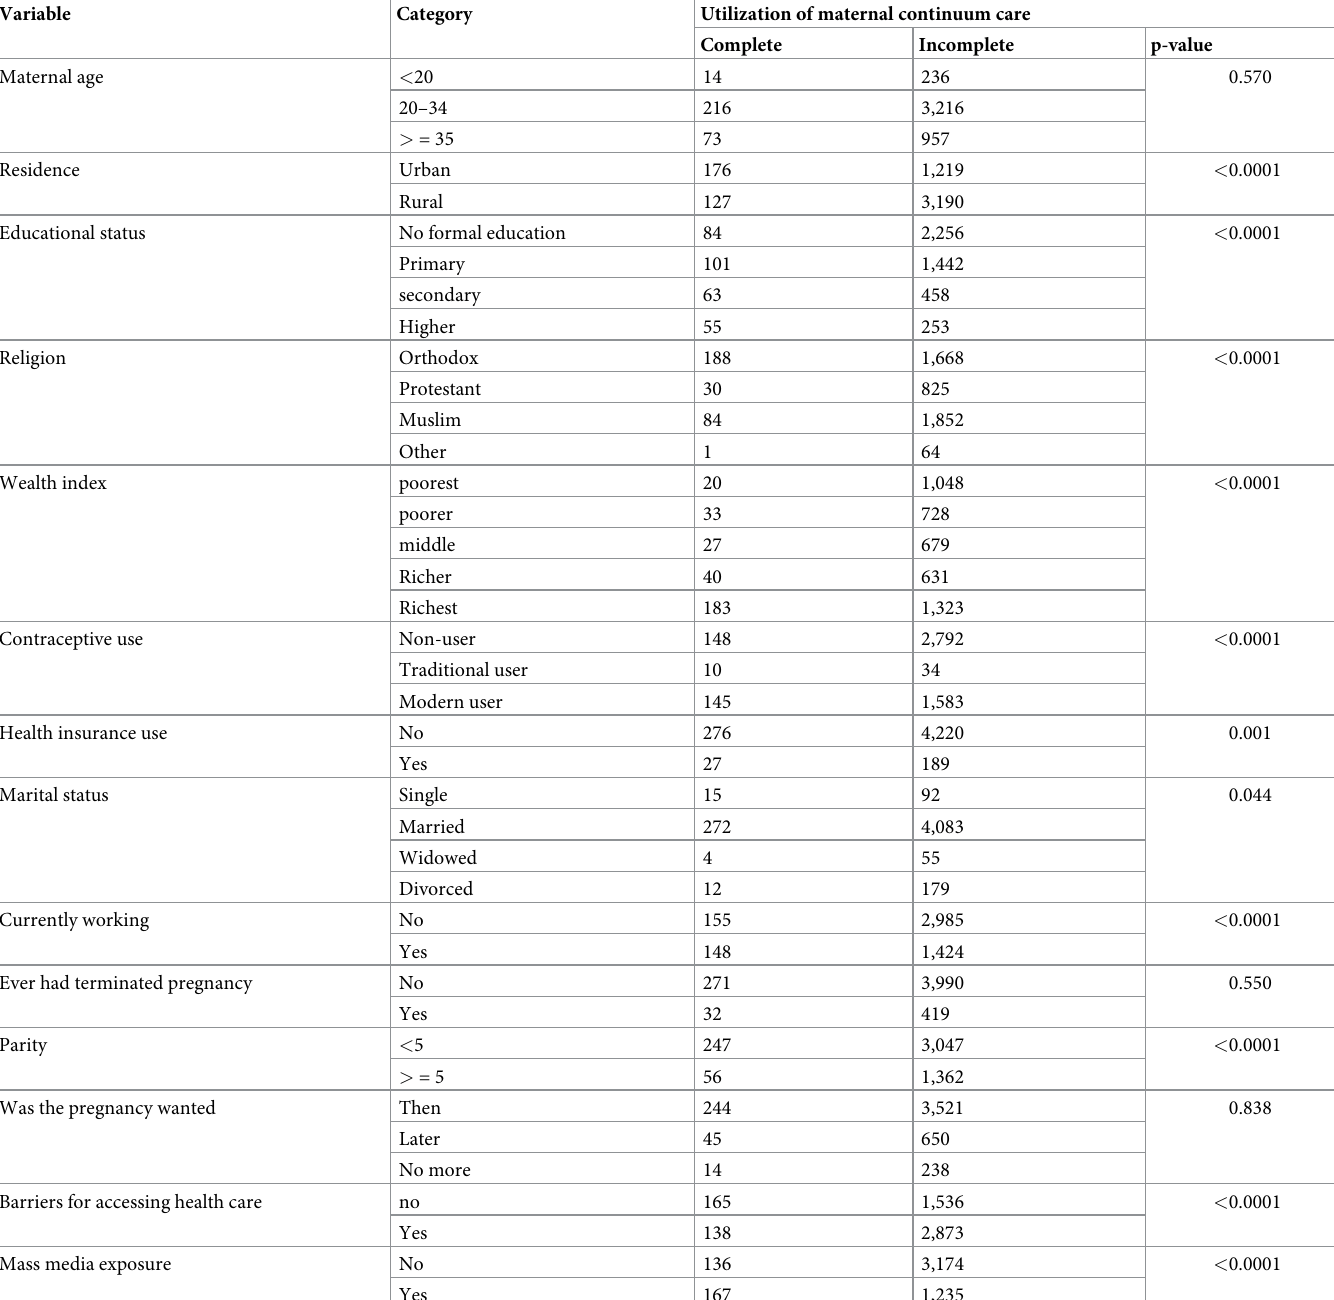
Table 2. Frequency distribution of maternal continuum of care among reproductive age women in Ethiopia, 2016 EDHS.